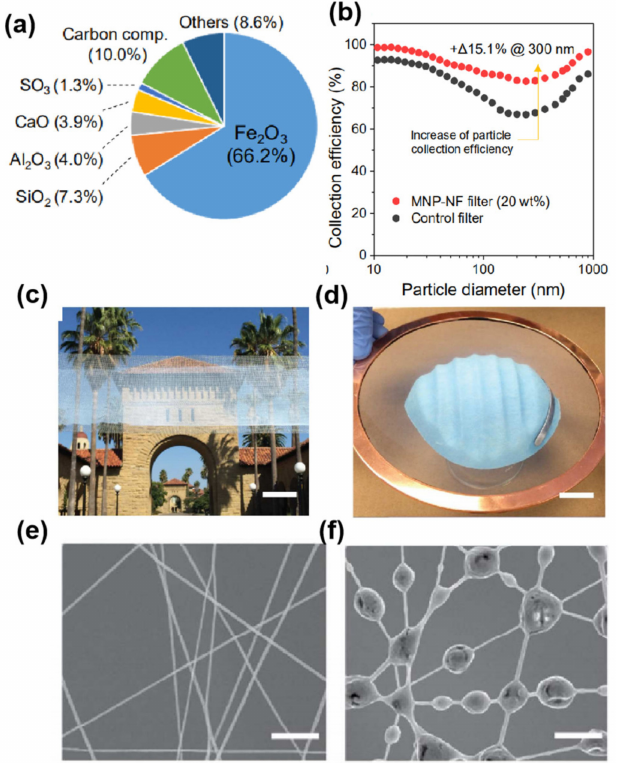
Figure 2. ( a ) Chemical composition of dust from a subway station in Seoul, South Korea. ( b ) Compar- ison of subway dust collection efficiency for a control filter versus a 20 wt % Fe 3 O 4 nanoparticle-NF filter. ( c ) Photograph of a roll-to-roll produced transparent air filter. Scale bar is 5 cm. ( d ) Photograph showing that freestanding nanofiber film can be easily transferred onto a facemask. Scale bar is 3 cm. ( e , f ) SEM images of Nylon-6 nanofibers before and after filtration. Scale bars in ( e , f ) are 2 µ m. ( a , b ) Reprinted with permission from the reference [36]. ( c – f ) Reprinted with permission from